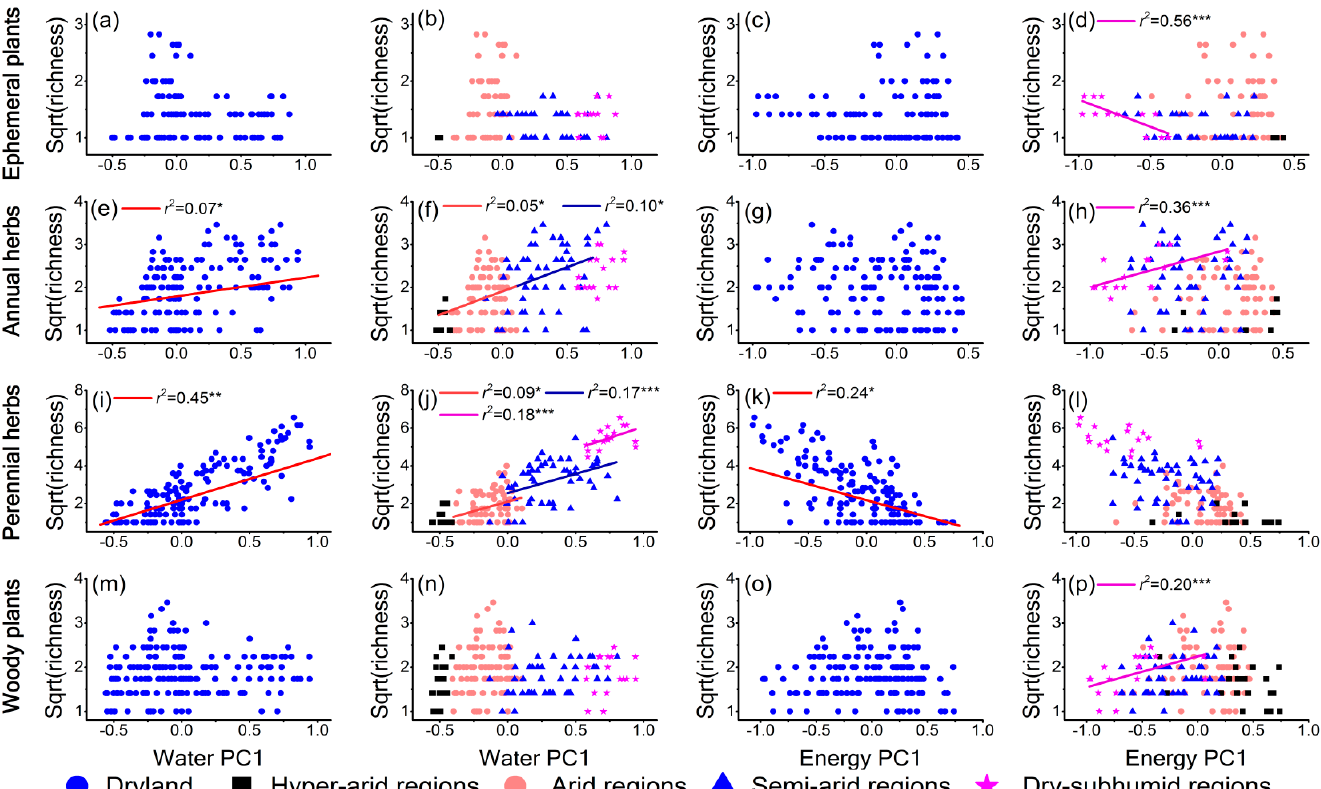
Figure 5. The relationship of plant diversity among different plant life-forms and water, energy across the entire dryland in China and the different aridity regions. Only significant trend lines ( p < 0.05) are shown. Plant diversity is expressed as the number of species in 900 m 2 in each site and is square-rooted in models, and r 2 is the adjusted coefficient of determination. ( a–d ) Ephemeral plants (dryland: n = 105 sites; hyperarid regions: n = 3 sites; arid regions: n = 54 sites; semiarid regions: n = 35 sites; dry-subhumid regions: n = 13 sites). ( e–h ) Annual herbs (dryland: n = 144 sites; hyperarid regions: n = 7 sites; arid regions: n = 73 sites; semiarid regions: n = 47 sites; dry-subhumid regions: n = 17 sites). ( i–l ) Perennial herbs (dryland: n = 149 sites; hyperarid regions: n =15 sites; arid regions: n = 68 sites; semiarid regions: n = 49 sites; dry-subhumid regions: n = 17 sites). ( m–p ) Woody plants (dryland: n =180 sites; hyperarid regions: n = 24 sites; arid regions: n = 89 sites; semiarid regions: n = 50 sites; dry-subhumid regions: n = 17 sites).